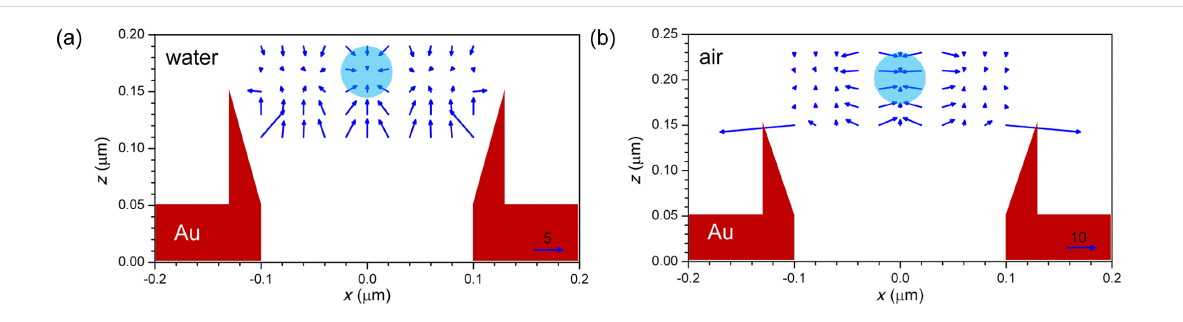
Figure 5: Arrow plot of the trapping force for plane-wave illumination in medium-to-substrate direction (as in Figure 4) at 760 nm wavelength for a 50-nm diameter polystyrene bead in (a) water and (b) air. The conical Au-well profile is schematically shown by the triangular shapes and the circle indicates the position of the bead in the central trap. The scale arrows at the lower right indicate forces of 5 and 10 pN/W/ μ m 2 .